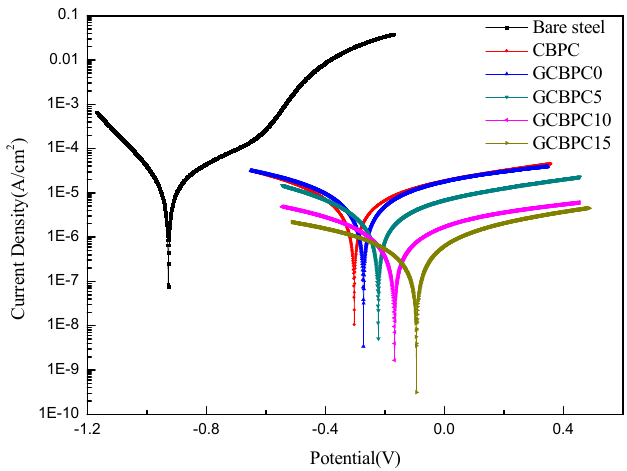
Figure 8. Potentiodynamic polarization curves of phosphate ceramic coatings. Table 5. Curing parameters based on the potentiodynamic polarization curves.